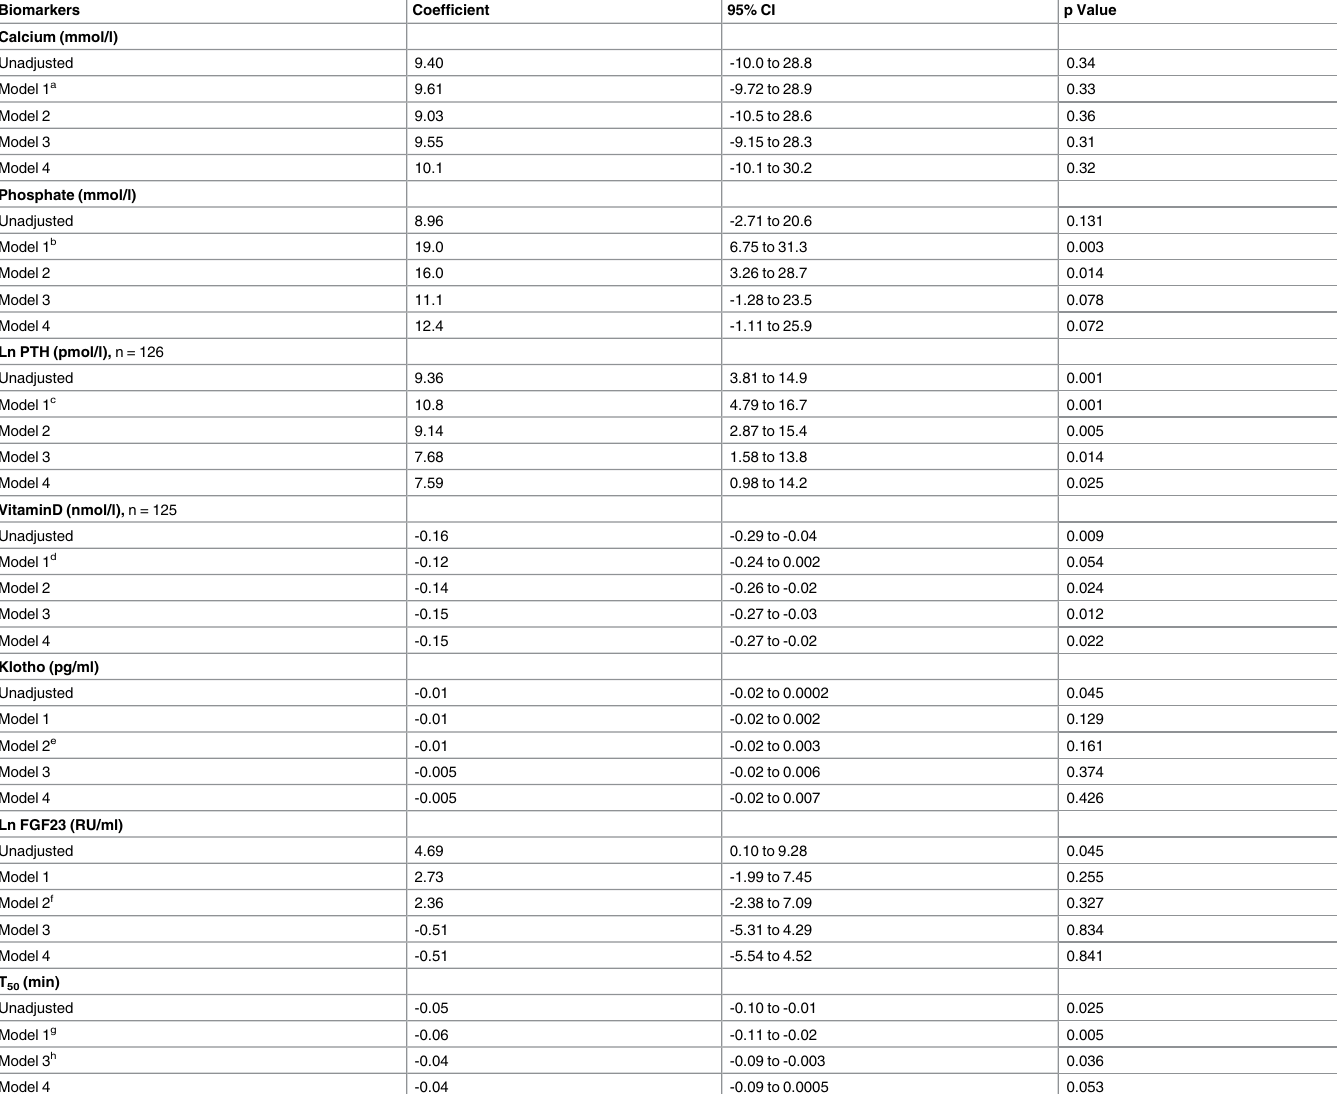
Table 3. Associations of serum biomarkers with interstitial fibrosis in kidney allograft recipients (n = 129). Univariateand multivariate linear regres- sion